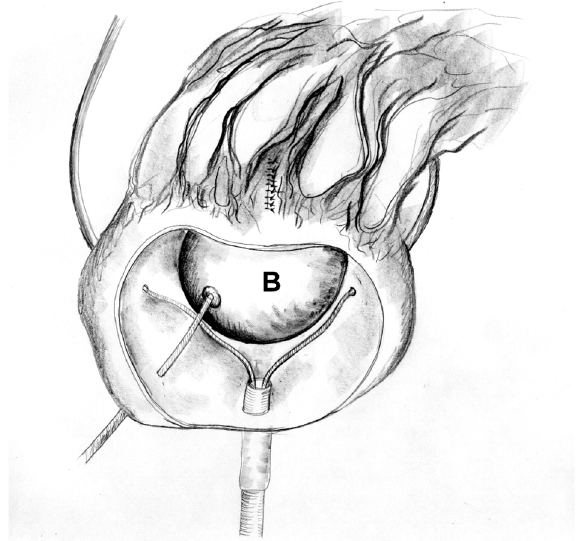
Figure 5 – Reimplantation of ureters. Note catheters in the ure- ters. The silicone balloon (B) is partially